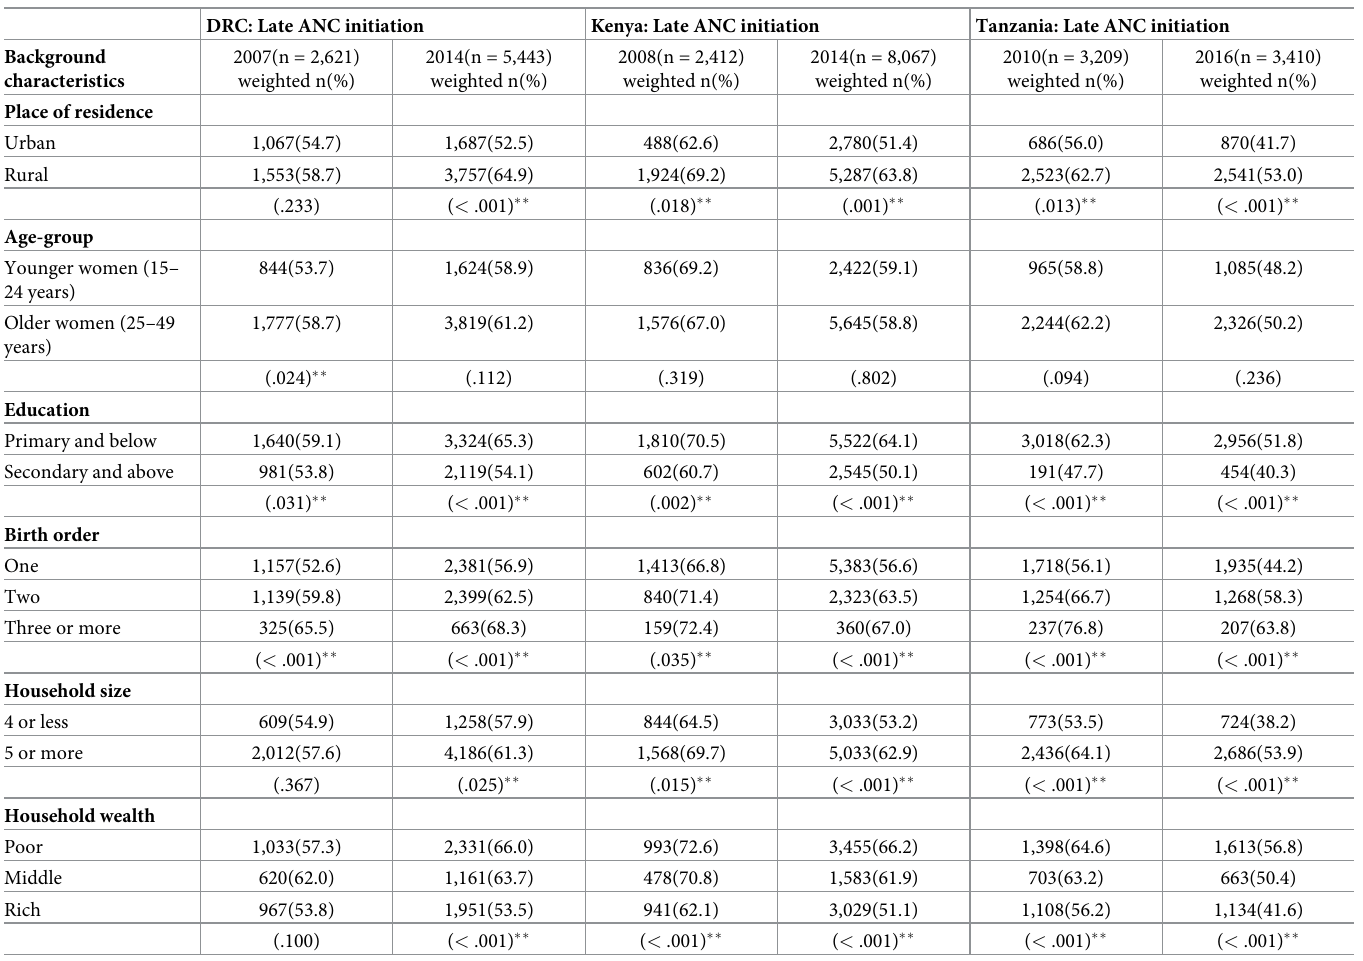
Table 2. Late ANC initiation by background characteristics in the DRC, Kenya and